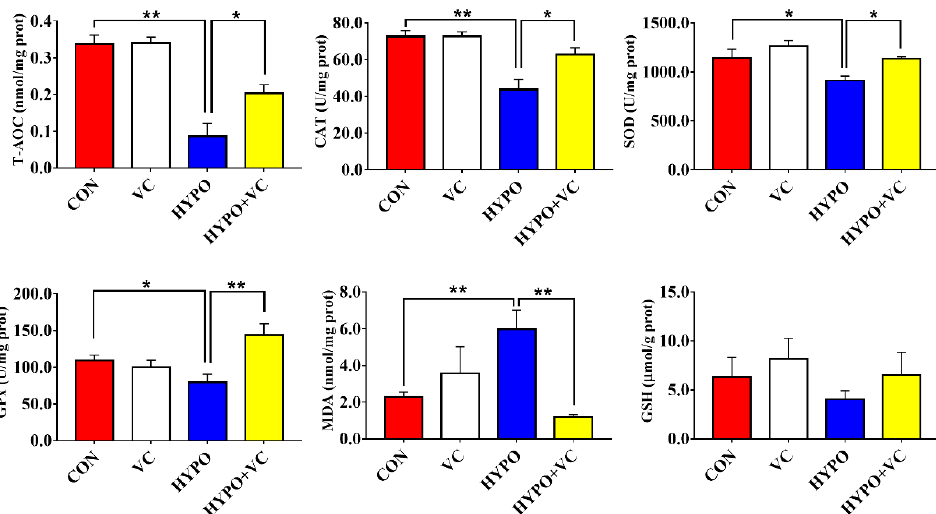
Figure 4. Changes in antioxidant enzyme parameters in the liver of gibel carp in the normal and hypoxia groups after 56 days of feeding with VC. The * or ** at the top of the bar chart indicates a significant difference between treatments; * indicates a significant difference ( p < 0.05), and ** indicates an extremely significant difference ( p < 0.01). All of the data are presented as mean ± standard error (n = 6). T-AOC — Total antioxidant capacity; CAT — Catalase; SOD — Superoxide dismutase; GP — Glutathione peroxidase; MDA — Malondialdehyde; GSH — Reduced glutathione.